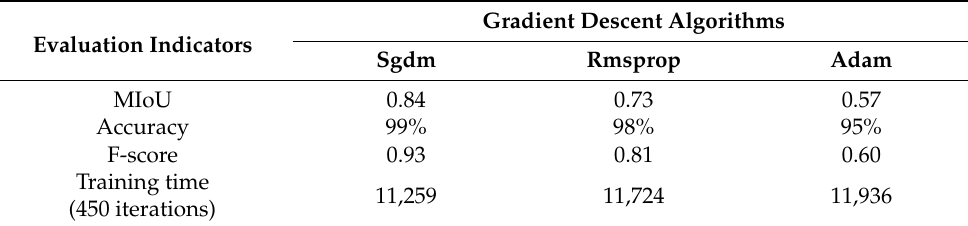
Table 5. Detection results of the improved DeepLab_v3+ using different algorithms. Evaluation